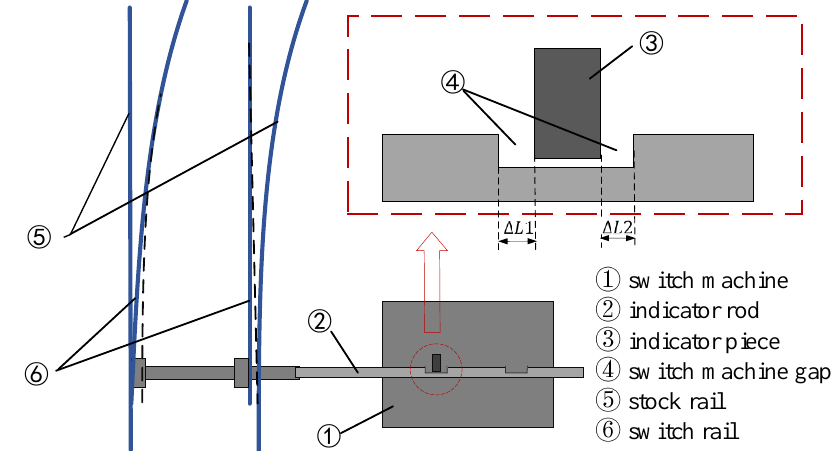
Figure 3. The relationship between gap and turnout.